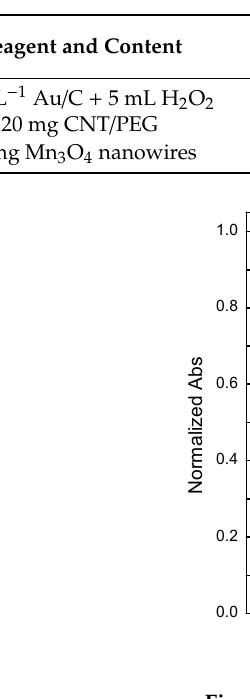
Table 2. Comparison of phenol removal with di ff erent reagents.